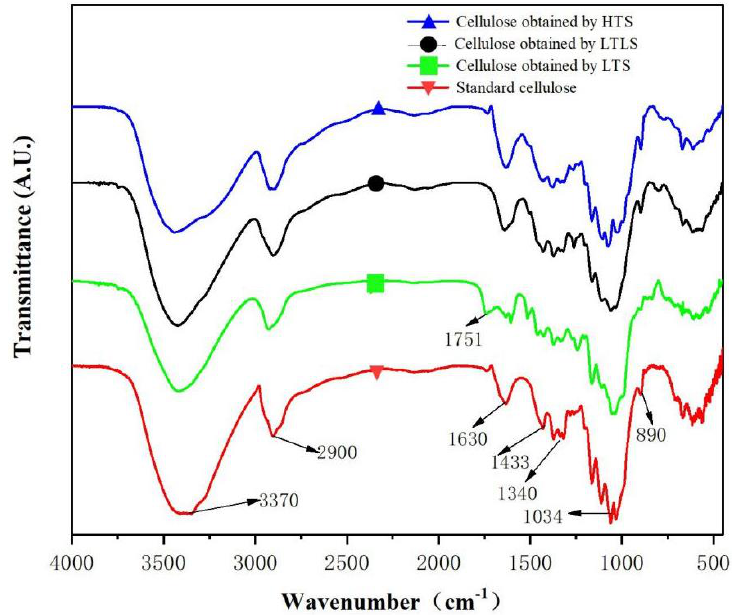
Figure 1. Infrared spectra of cellulose obtained using the LTS, LTLS, HTS, and standard